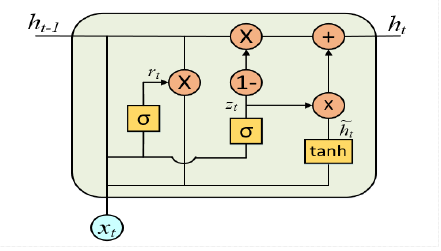
Figure 2. The basic structure of